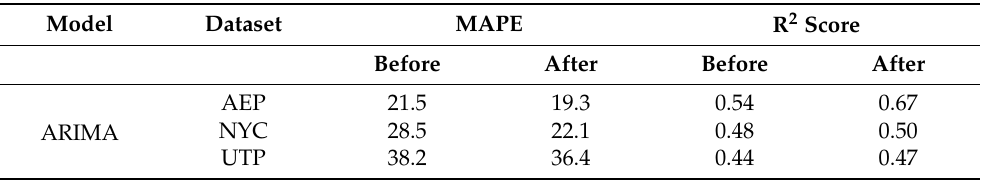
Table 3. ARIMA model performance on A.E.P., N.Y.C., and U.T.P. datasets before and after parametric